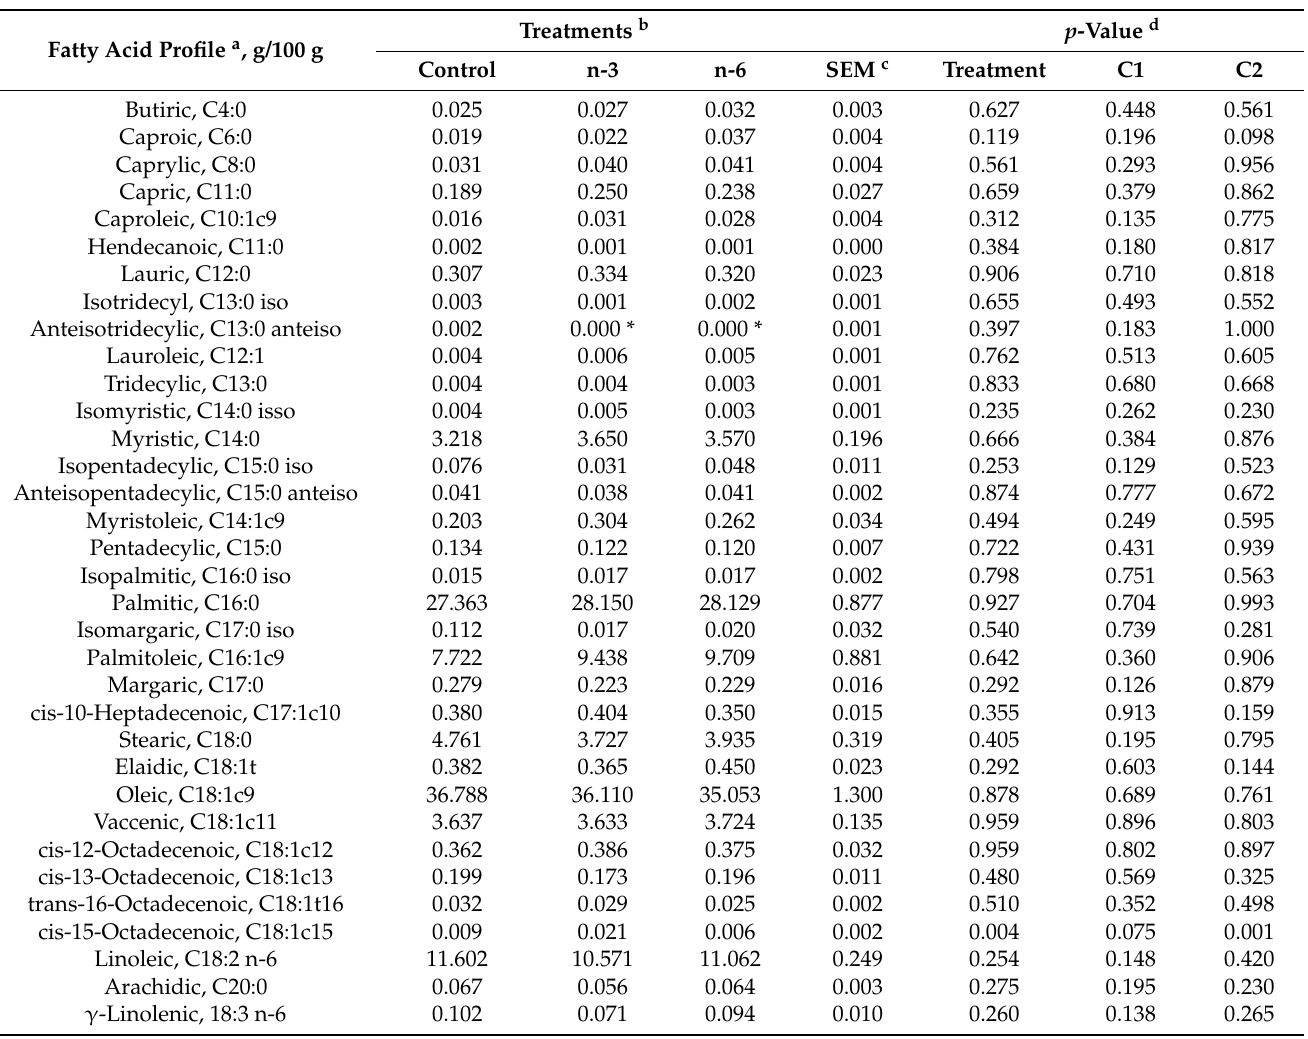
Table 9. Effect of supplementation of milk enriched with n-3 and n-6 on the fatty acid profile of sows’ milk sampled at d 14 of